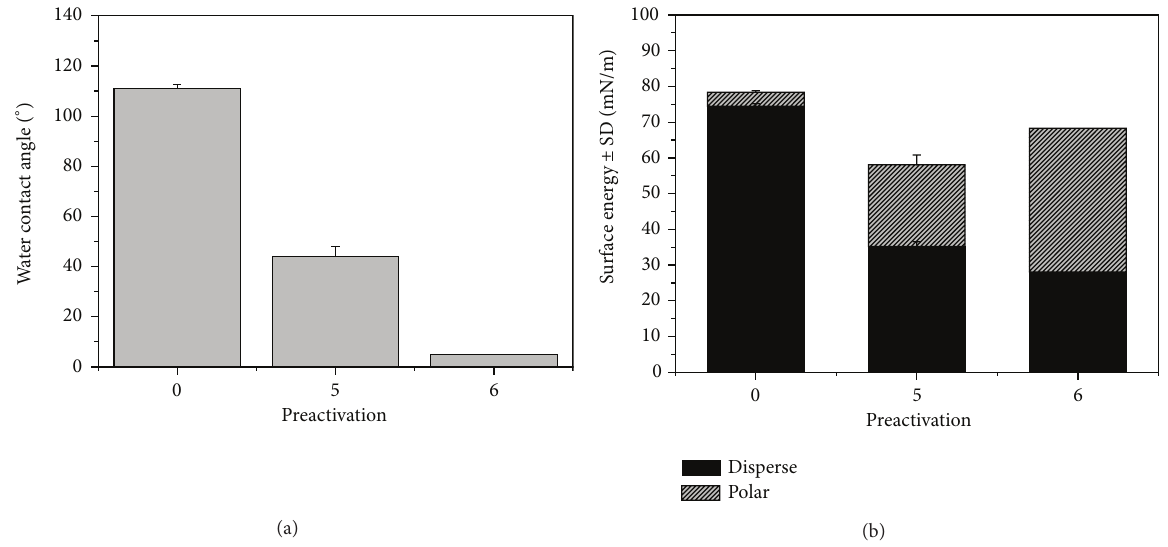
Figure 5: Water contact angles (a) and surface energies (b) of PPAAm-coated fiber meshes after fiber preactivation by methods number 5 and number 6, respectively, compared to the PPAAm-coated fiber meshes without preactivation (number 0) ( 𝑛 = 5 ).